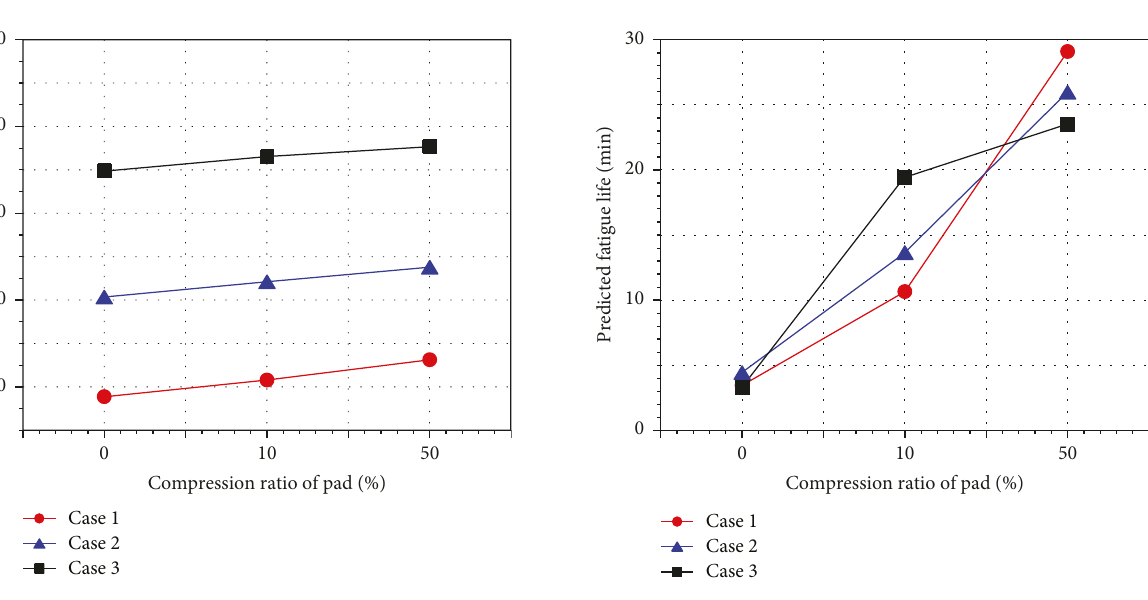
Figure 16: Fatigue life on solder joint for CCGA624 package with respect to the fatigue life in each